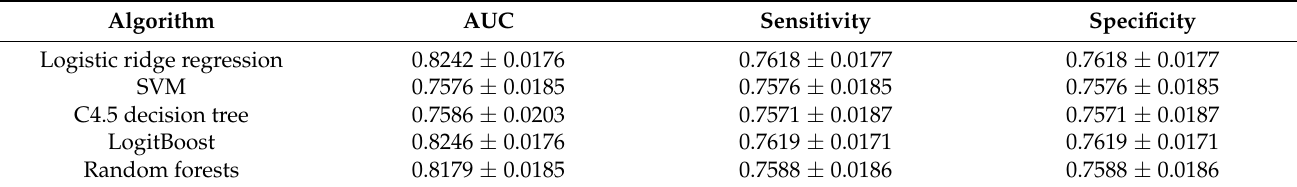
AUC = the area under the receiver operating characteristic curve; MDD = Major Depressive Disorder; SVM = support vector